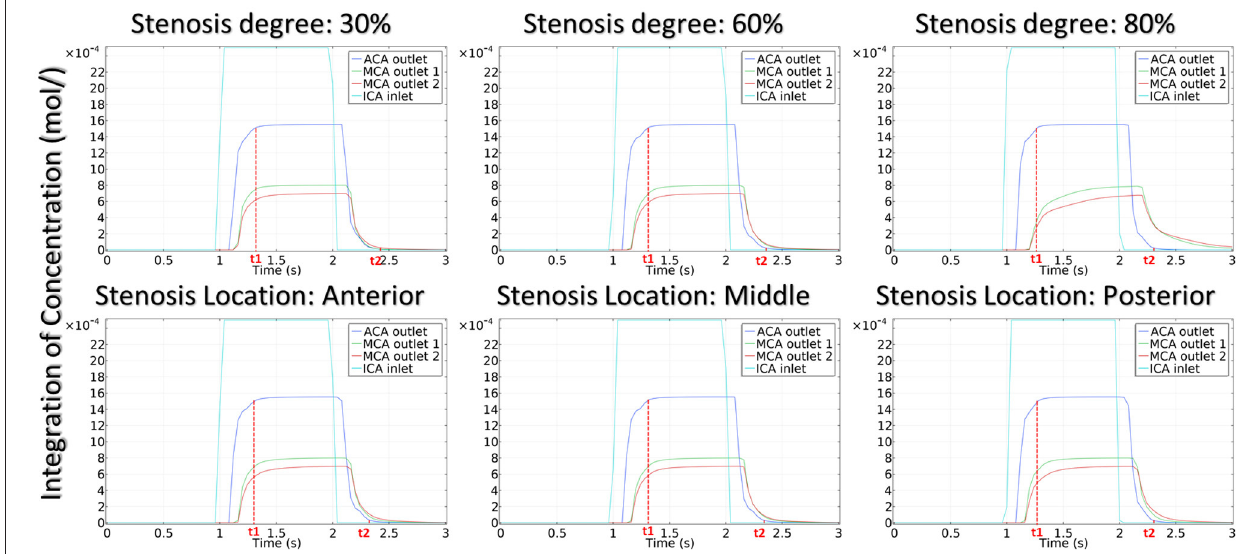
FIGURE 7 | The integration of contrast material concentration at inlet and outlets.